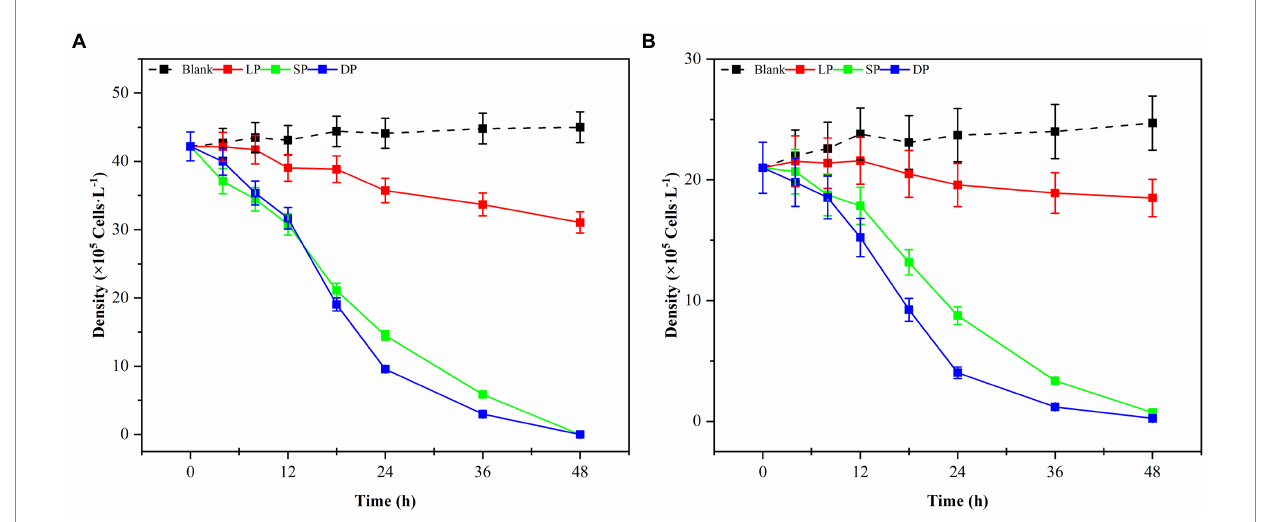
FIGURE 1 Changes in the density of G. catenatum (A) and K. mikimotoi (B) with time were observed during the different growth stages of Ps3 bacterial solution (LP-Logarithmic Phase; SP-Stationary Phase; DP-Death